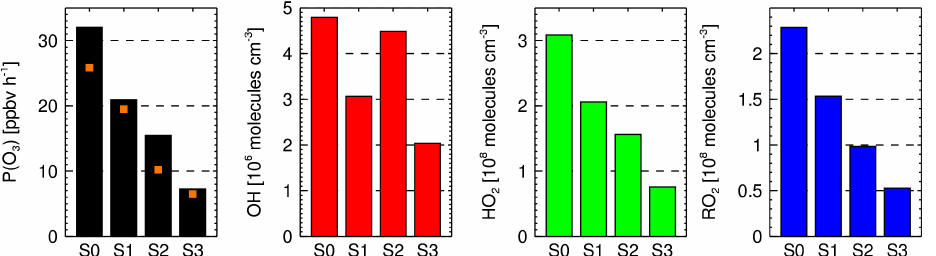
Fig. 7. Daytime average O 3 production rates and concentrations of OH, HO 2 , and RO 2 under scenarios S0, S1, S2, and S3. The yellow squares show the net O 3 formation rates (P(O 3 ) − L(O 3 ) ).